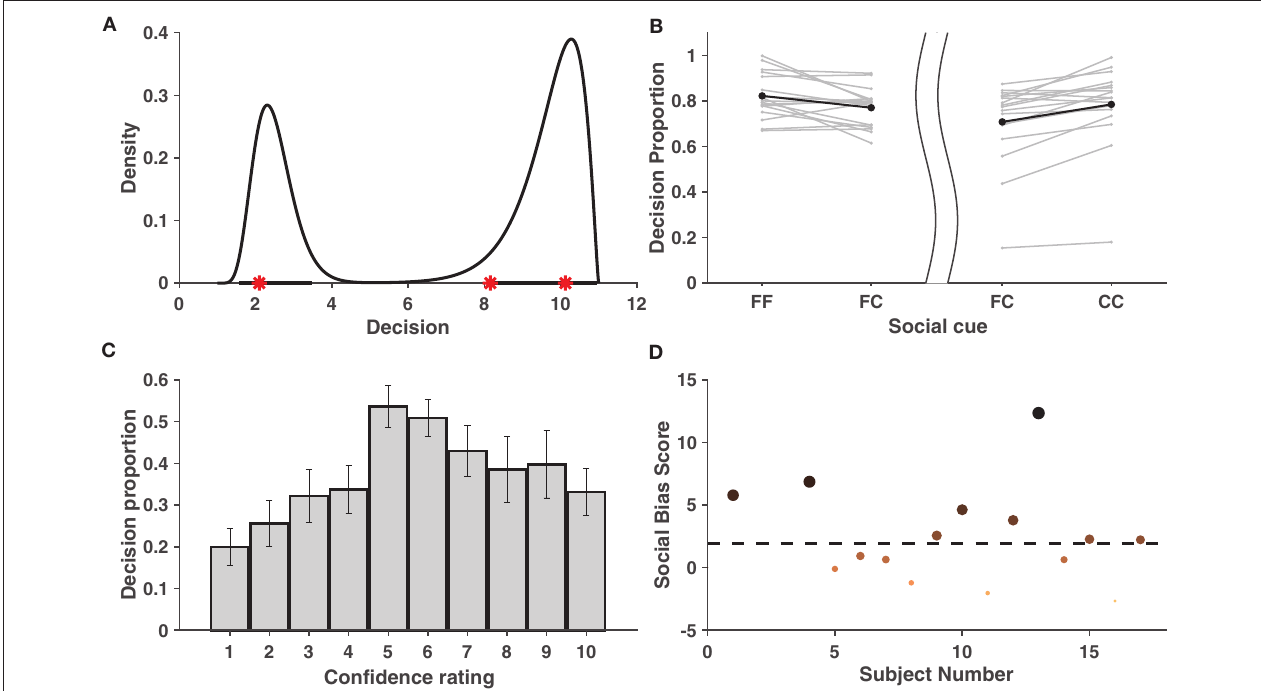
FIGURE 2 | Behavioral Data Analysis. (A) Estimated probability density function based on the training data set shown for one subject when k 1 3 and k 2 10. Bold = = lines on x-axis represent the 95% HPDR, and red stars represent the test observations for a subject. The test observations fall within the HPDR. (B) Increase in average proportions of decisions around the individual decision when viewing concurring cues vs. viewing neutral cues. The left part of the figure considers cases when the individual decision was a face, while the right part considers cases when it was a car. The bold dots depict the average across the individuals. (C) Mean proportion of decisions toward conflicting cues across individuals. Figure shows that crossover happens for all cases of individual confidence and is most prominent when individual decision confidence is low (5,6). Error bars denote SD. (D) Social bias ranking of subjects, indicating their tendency to be influenced by the cue ± shown. Larger and darker dots indicate subjects that are more socially influenced. The dotted line parallel to the x-axis depicts the significance